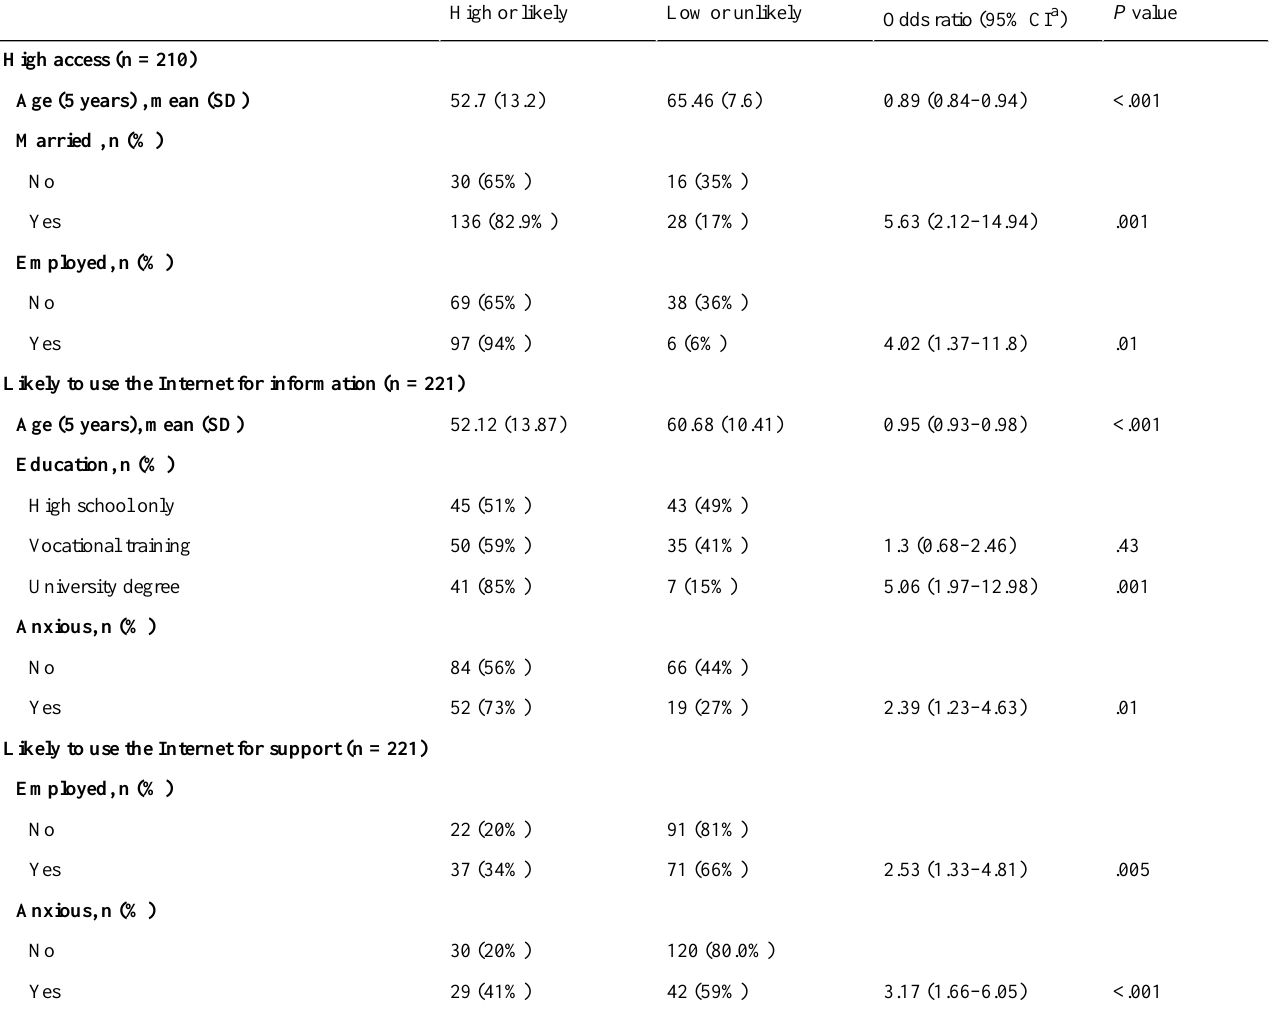
Table 4. Logistic regression analysis of factors associated with high reported Internet access, likelihood of using the Internet for information, and likelihood of using the Internet for